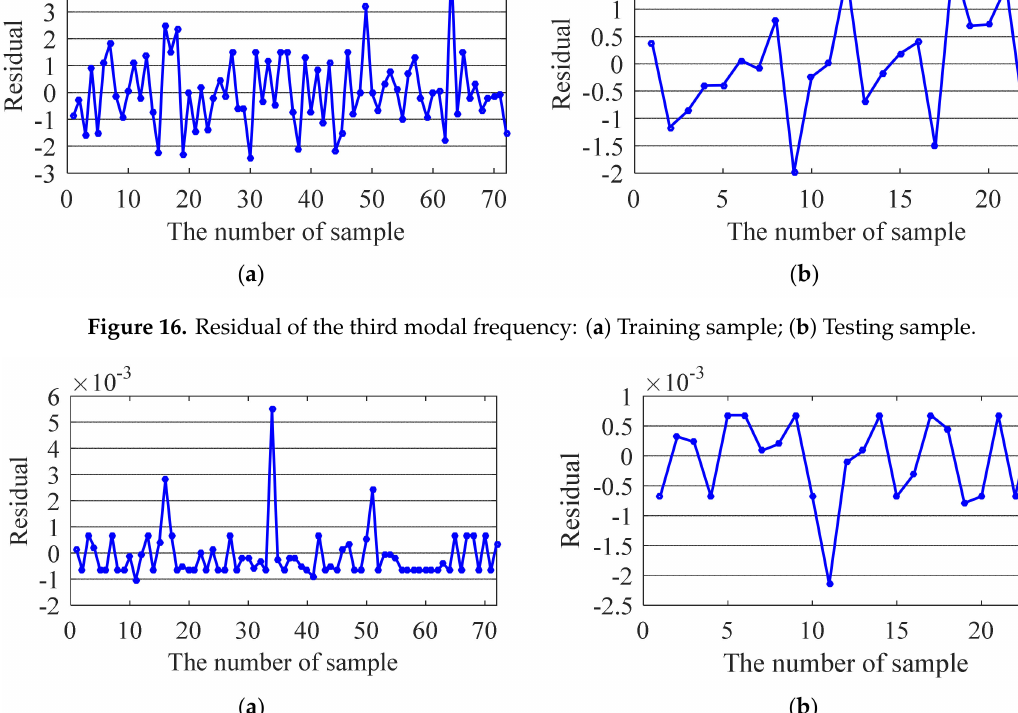
Figure 17. Residual of the fourth modal frequency: ( a ) Training sample; ( b ) Testing